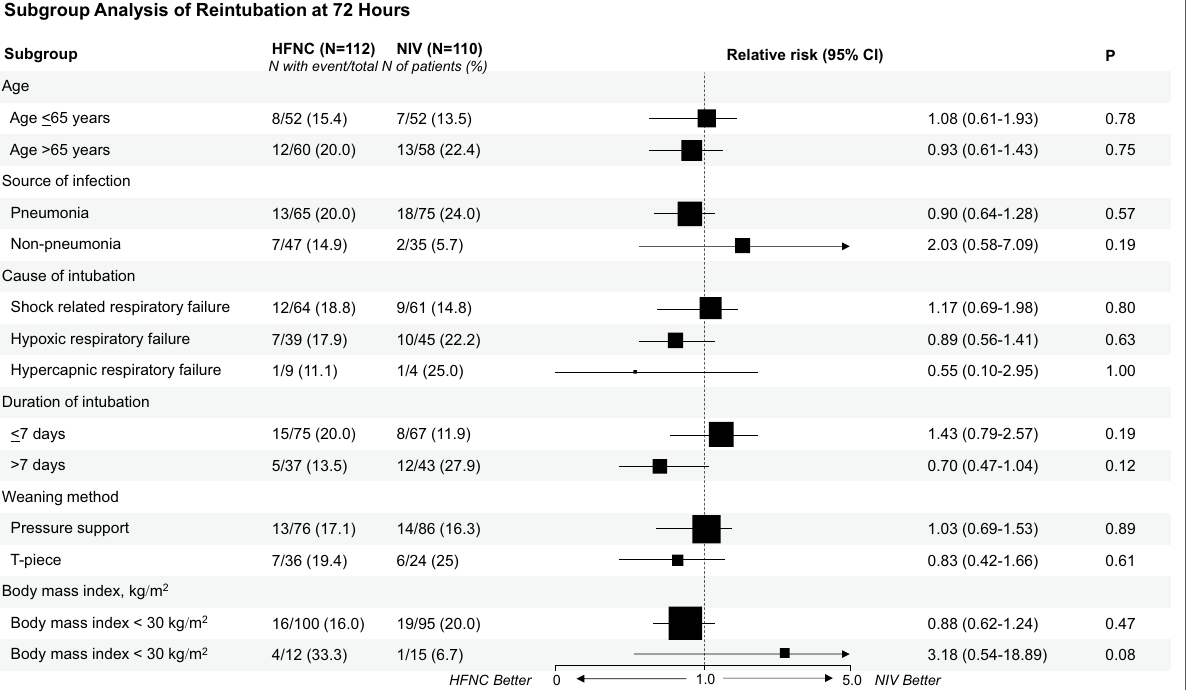
Fig. 3 Risk of reintubation at 72 h after extubation, according to subgroup. Subgroup analysis according to six patients’ characters. The location of square represents the relative risk and the size of square reflects the relative numbers in each subgroup. The horizontal bars represent 95% confidence intervals